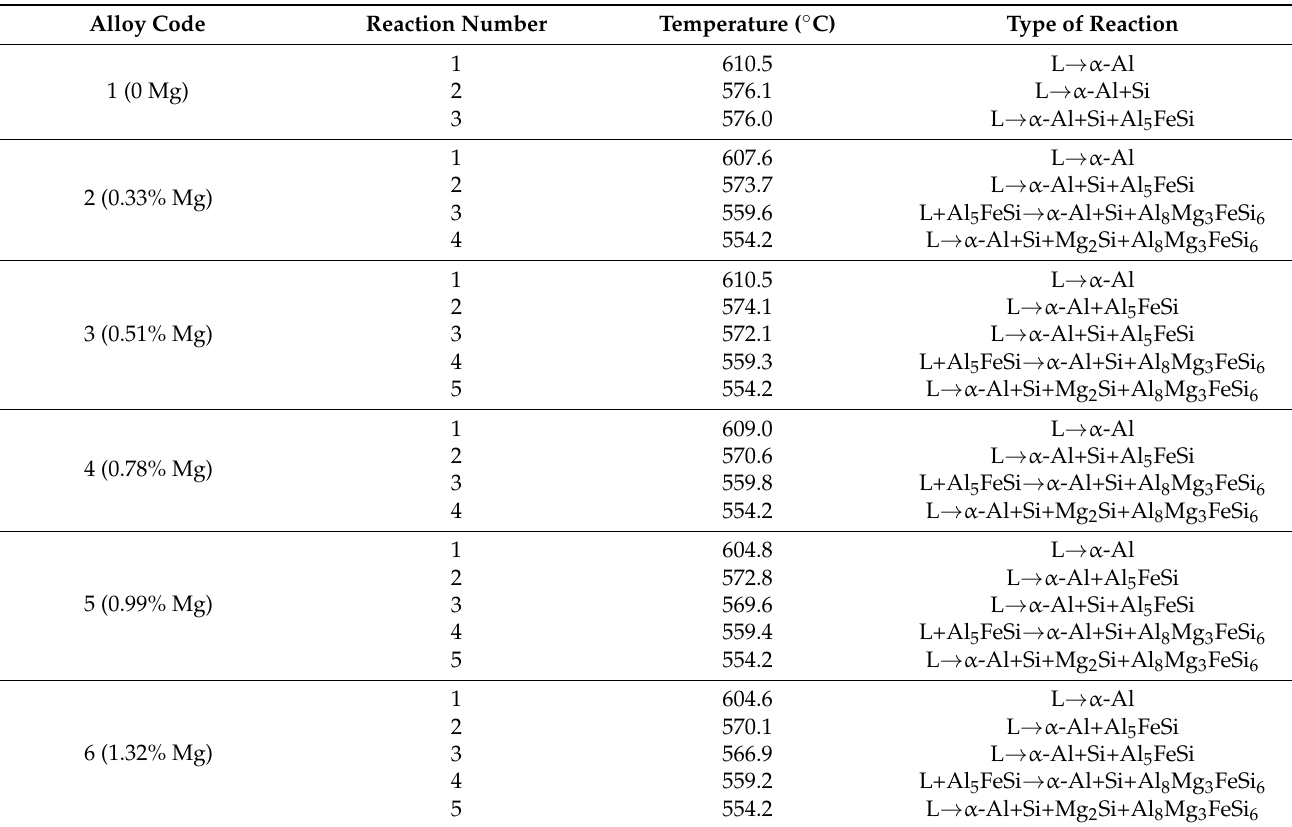
Table 3. Main reactions observed from the thermal analysis diagrams of the experimental alloys. Alloy